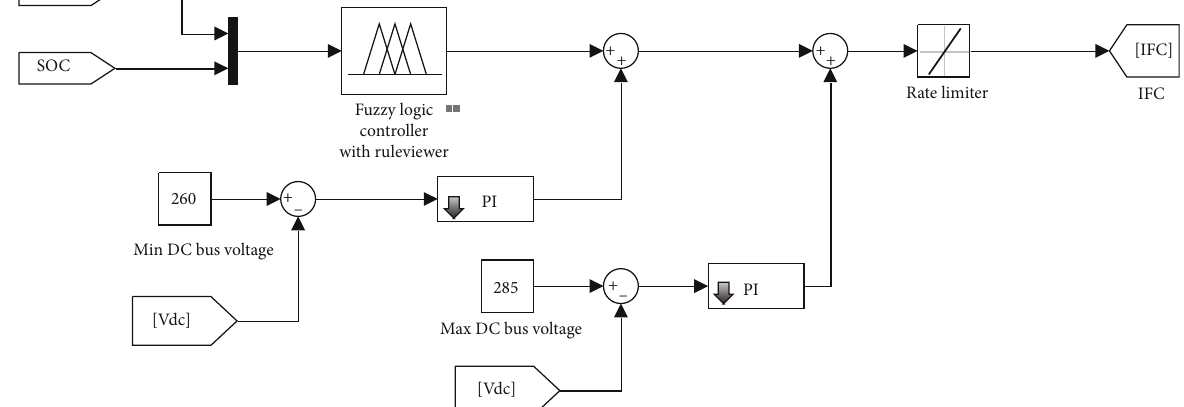
Figure 8: Schematic of the power management strategies.